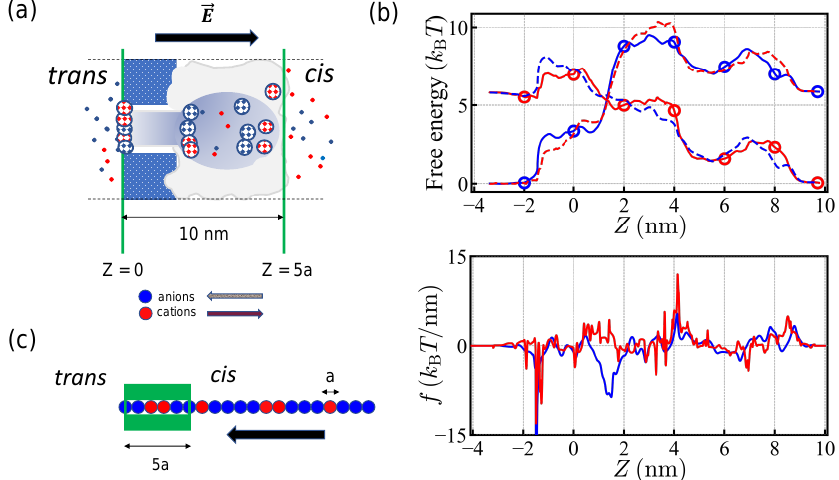
Figure 1. ( a ) Schematic representation of an α -hemolysin pore. The mushroom-shaped complex is approximately 10 nm long. The colored patches represent charged regions inside the pore, a positively charged cis protrusion and a negatively charged trans edge. ( b ) Translocation free energy (top) and corresponding translocation force (bottom) for small ions, K + (red) and Cl − (blue), in α -hemolysin, with a transmembrane potential of + 150 mV (solid lines) and − 150 mV (dashed lines). The potential is in favor of translocation of negative (positive) ions from cis -to- trans (reverse) direction with + 150 mV. The free energy values are taken from Figure 7 of Ref. [22] and those values used for the MC simulations are indicated by circles. ( c ) Schematics showing the initial position of the PA chain in the MC simulation for translocation from the cis to the trans